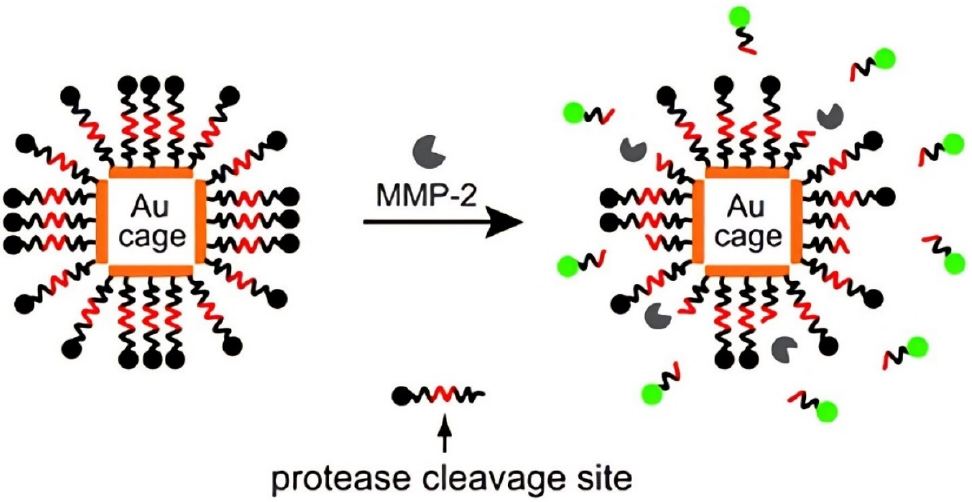
Figure 1. Schematic illustration of enzyme-responsive AuNCs conjugated with FITC-labeled peptides. Reprinted/adapted with permission from Ref. [30]. Copyright 2011, The Royal Society of Chemistry.